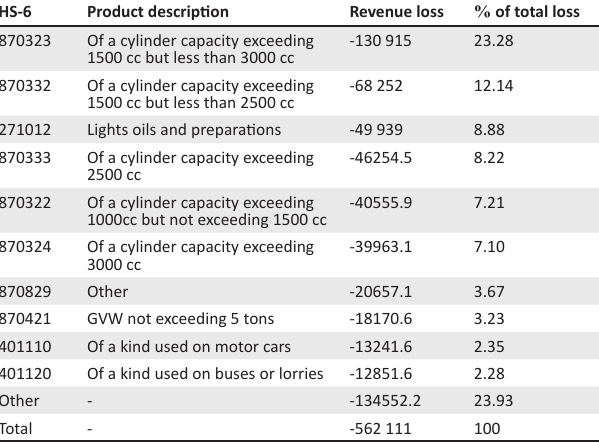
TABLE 5: Top 10 largest losses in South African products revenue after the Free Trade Agreement with the European Union (US$ 000). HS-6 Product